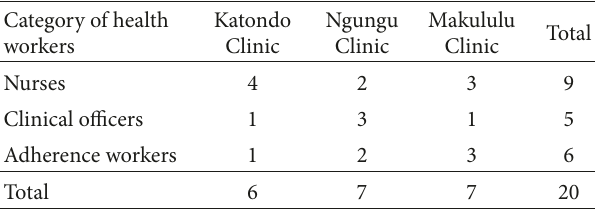
Table 2: Healthcare workers in three